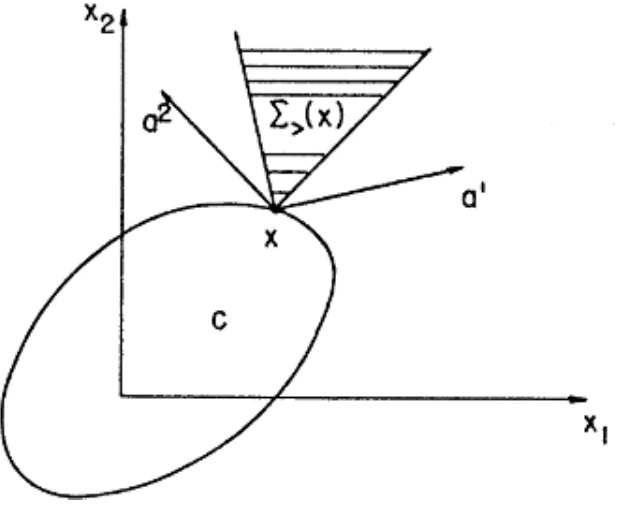
Figure 3. Illustration of the significance of C and ∑ > ( x ) [9].